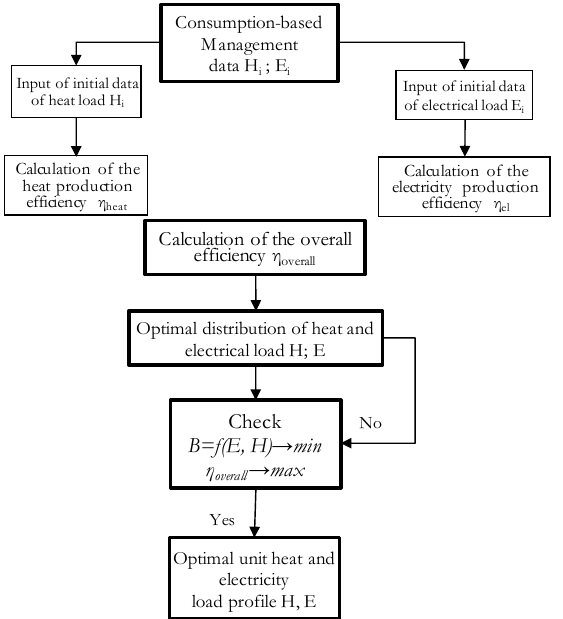
Figure 5. Flowchart of the application of the demand-side management algorithm to solve the economic dispatch problem of the CHP unit.